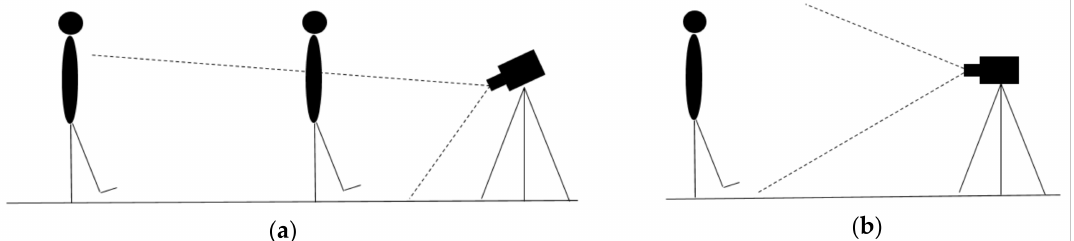
Figure 4. Different recording angles depending on the range of distances to be measured. ( a ) 0.5 and 1 m distance, as well as the walking test. ( b ) 1.5, 2, 3 and 4 m